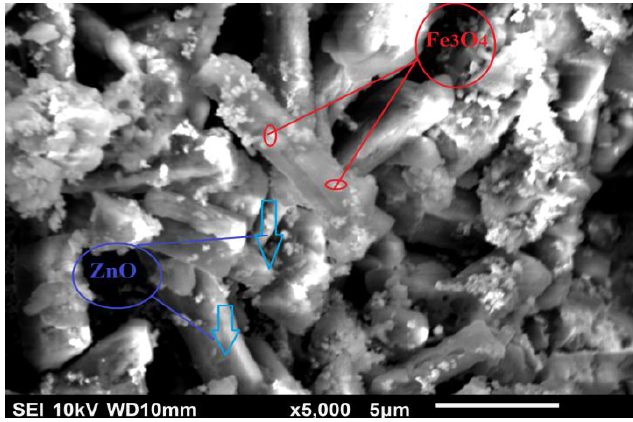
Figure 2. Scanning electron microscopy (SEM) images of the magnetic ZnO nanotubes.